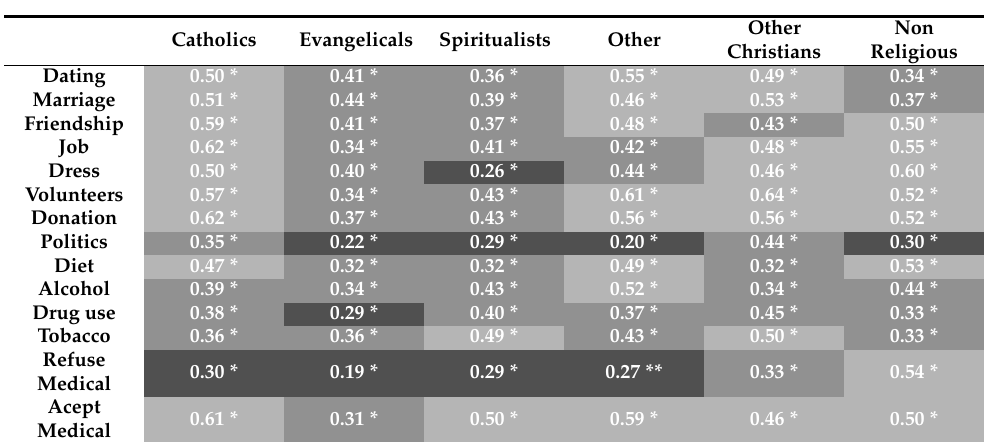
Table 2. Correlations between generic questions, daily decisions, and health-related questions. Catholics Evangelicals Dating